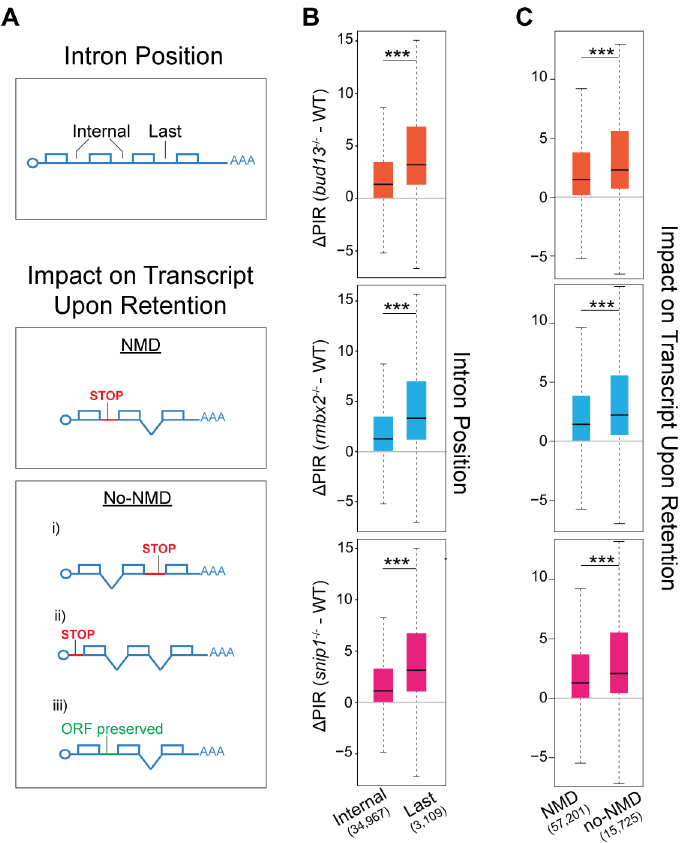
Fig 4. Genome-wide analysis of intron retention in RES complex mutants. (A) Schematic representation of intron features analyzed in (B) and (C). Top: Intron position. “Internal” introns correspond to all introns excluding the first two and last three introns. Bottom: NMD vs non-NMD triggering introns. Introns predicted to cause NMD upon retention introduce a premature termination codon (PTC) further than 50 nucleotides upstream of an exon-exon junction. Introns predicted not to cause NMD (noNMD) may correspond to: (i) last introns, (ii) introns in UTRs or non-coding genes, or (iii) introns that preserved the ORF upon retention (multiple of three nucleotides with no in- frame stop codons). (B) Box plots showing the Δ PIR of last and internal introns in the three different mutant of the RES complex. Only genes with more than 10 introns were considered for the analysis. bud13 (cid:3)(cid:3)(cid:3) P = 4.37x10 -201 ; rbmx2 (cid:3)(cid:3)(cid:3) P = 2.98x10 -202 ; snip1 (cid:3)(cid:3)(cid:3) P = 4.76x10 -195 (Wilcoxon rank sum test). (C) Box plots showing the Δ PIR of introns predicted to trigger nonsense mediated decay (NMD) upon retention and those predicted not to trigger NMD (no- NMD) in the three different mutant of the RES complex. bud13 (cid:3)(cid:3)(cid:3) P = 5.83x10 -208 ; rbmx2 (cid:3)(cid:3)(cid:3) P = 4.94x10 -184 ; snip1 (cid:3)(cid:3)(cid:3) P = 1.74x10 -183 (Wilcoxon rank sum